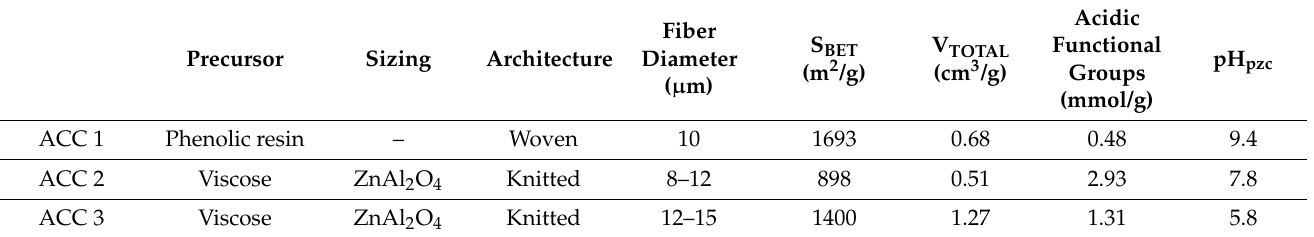
Table 2. Morphological, physico-chemical and textural characteristics of the three ACC